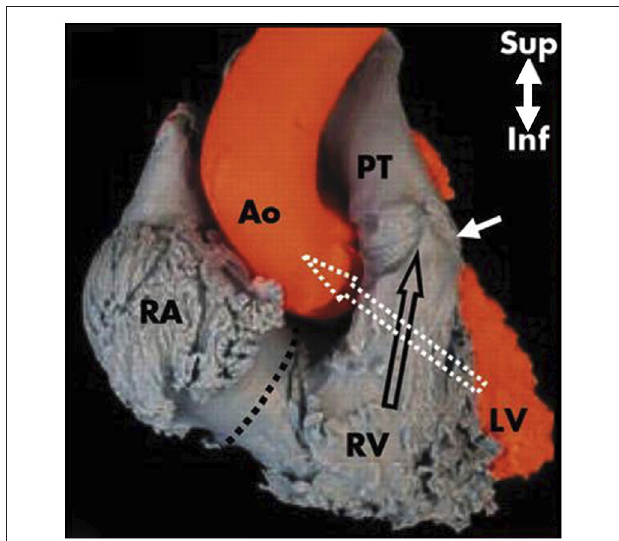
FIGURE 10 | The right outlet portion of the ventricular septum is smooth and has three components. The largest is the infundibular septum, which separates the pulmonary valve (with arrow) from the aortic and TV. A second part of the outlet portion of the septum is the anterior extension of the trabecular septomarginalis (septal band). A third small, very anterior portion is a narrow extension superior to the trabecular septum. The axes of the right and left ventricular outflow tracts differ significantly. That of the RV is almost vertically oriented, whereas that of the left ventricle angles sharply to the right, a characteristic criss-cross feature (white and black empty arrows), visible under fluoroscopy in the left anterior oblique projection and in the parasternal long axis view by two-dimensional echocardiography. RA, right atrium; Ao, Aorta; RV, right ventricle; PT, pulmonary trunk; LV, left ventricle. Modified from Ho et al.